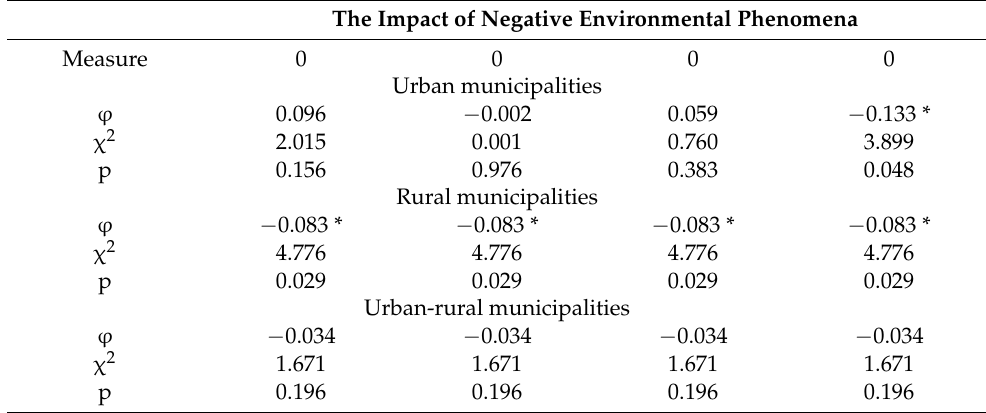
Table 3. Values of ϕ –Yule correlation coefficients between the impact of negative environmental phenomena and the type of regeneration program in urban, rural and urban–rural municipalities. The Impact of Negative Environmental Phenomena Measure